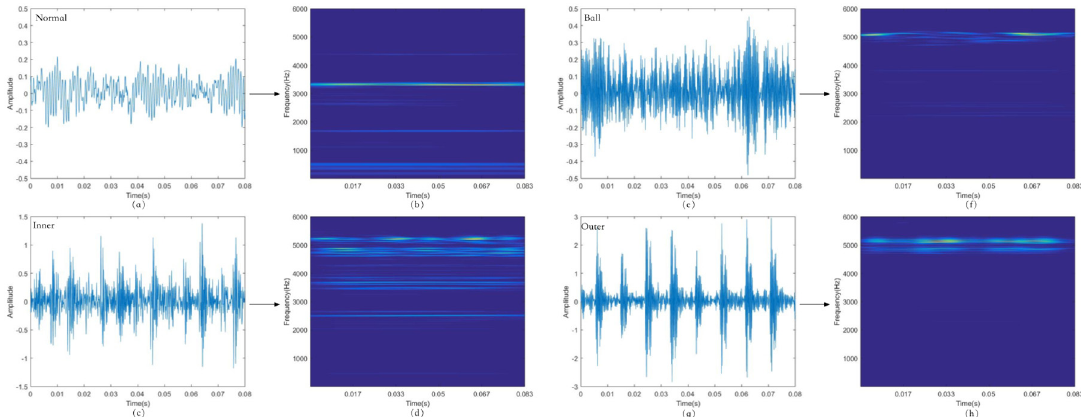
Figure 3. The vibration signal converted to a time–frequency representation (TFR) image by continuous wavelet transform: ( a ) waveform for the sample in normal conditions; ( b ) TFR image for the sample in normal conditions; ( c ) waveform for the sample with an inner raceway fault; ( d ) TFR image for the sample with an inner raceway fault; ( e ) waveform for the sample with a ball fault; ( f ) TFR image for the sample with a ball fault; ( g ) waveform for the sample with an outer raceway fault; ( h ) TFR image for the sample with an outer raceway fault.